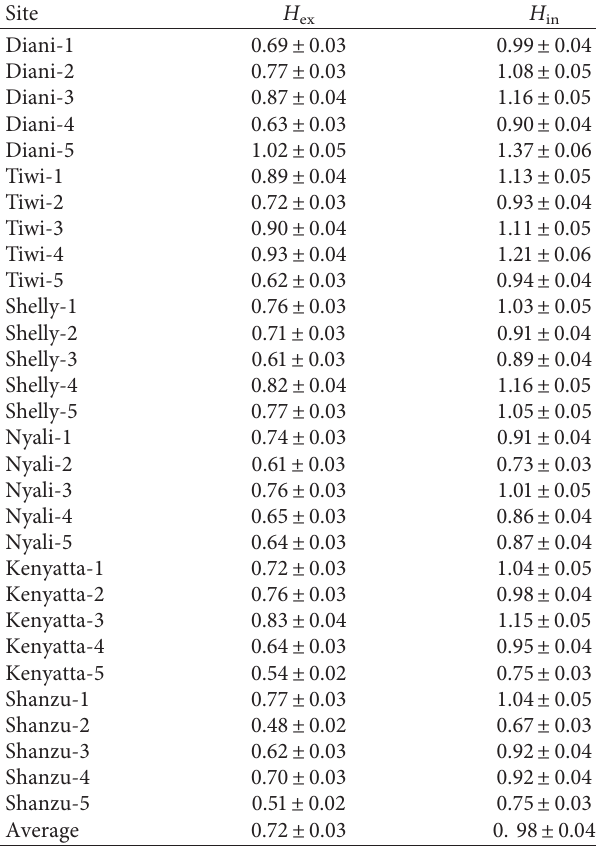
Figure 3: Radium equivalent values in the samples analyzed in this work. The solid line indicates an average safety limit value of 370Bq/kg [16]. Table 3: The internal and external hazard indices of the sand samples and the averages of each